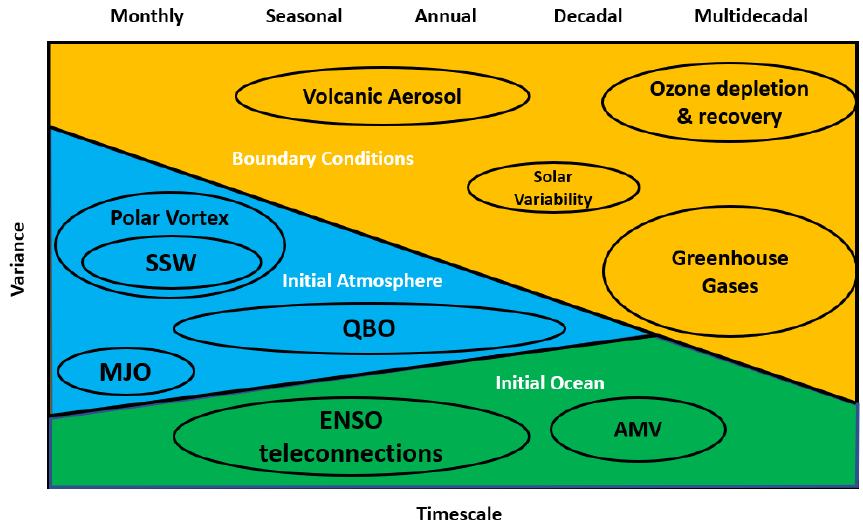
Figure 1. Schematic representation of the role of the stratosphere in long-range prediction showing the transition from initial-condition predictability in the atmosphere (blue) and the ocean (green) to boundary-condition predictability at longer timescales (orange). Individual mechanisms involving the stratosphere are labelled in black. The width of the ellipses in the timescale direction shows the approximate range over which each phenomenon provides predictability. The width of the ellipses in the variance direction shows their relative contributions to forecast